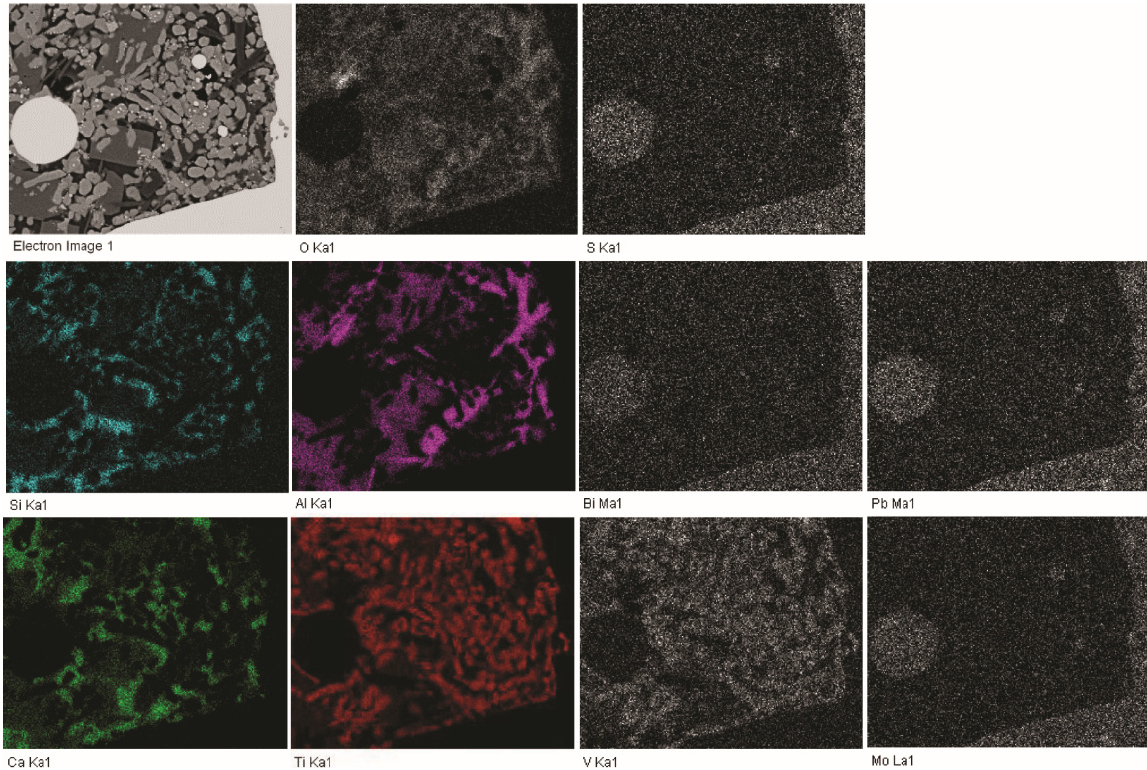
Figure 9. Accumulation of impurities in the steel melt B after FeTi alloying (FE-SEM-EDS; mag. 5000×; SEI and the distributions of elements O, S, Si, Al, Bi, Pb, Ca, Ti, V,